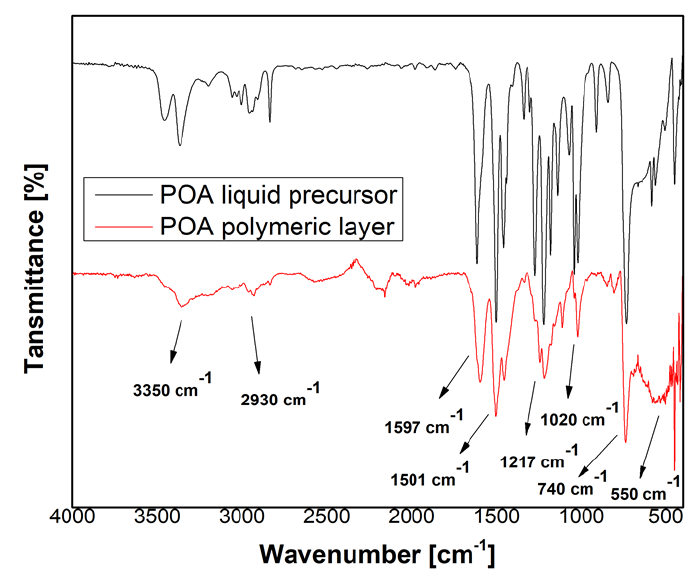
Figure 9. FTIR spectrum of the poly( o -anisidine) liquid precursor (black line) and polymer (red line). Table 3. IR spectral bands identified in the PANI spectra.